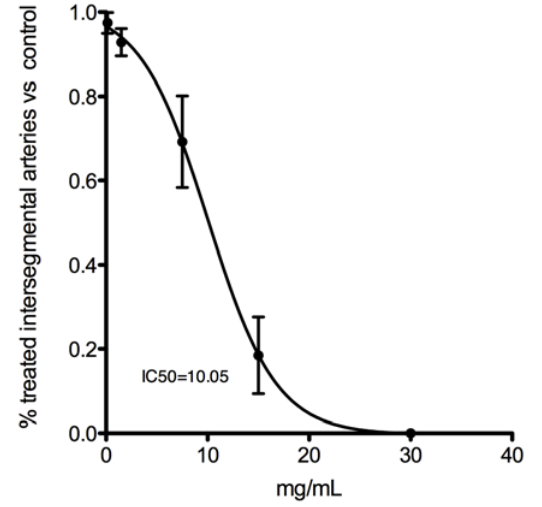
Figure 11. Dose response curve representative of the effect of GCL extract on zebrafish embryonic angiogenesis. IC was calculated plotting the percentage of trunk vessels 50 completely formed in treated animals vs. control animals against GCL extract concentration. Extract concentration ranged from 0.15 to 30 mg Cc mL − 1